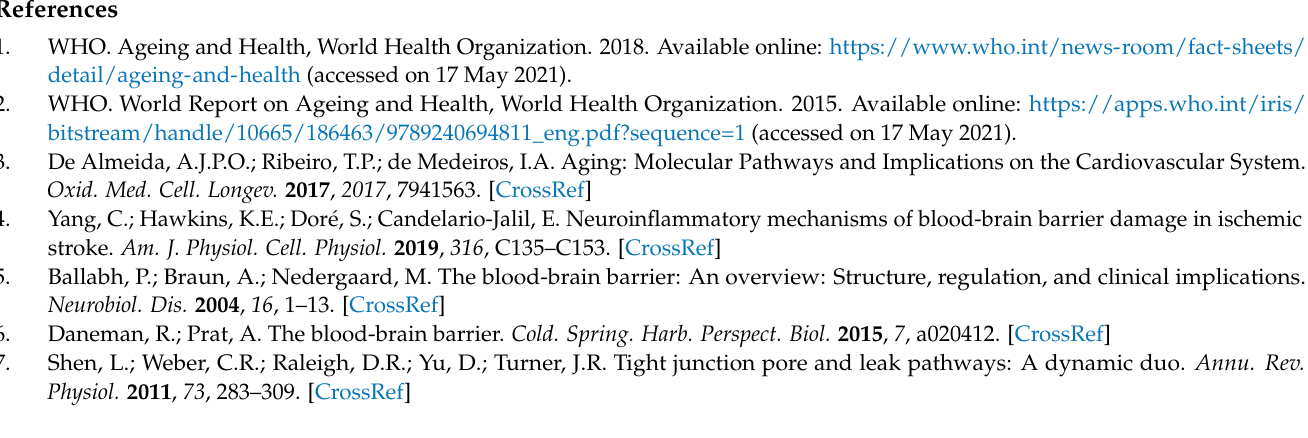
Figure S2: NOX5 detection by flow cytometry. Figure S3: Nitrotyrosine immunofluorescence of aging mice. Figure S4: Alterations in mRNA expression of the redox pathway components due to aging and NOX5. Figure S5: Locomotor activity tests. Figure S6: Occludin and ZO-1 mRNA